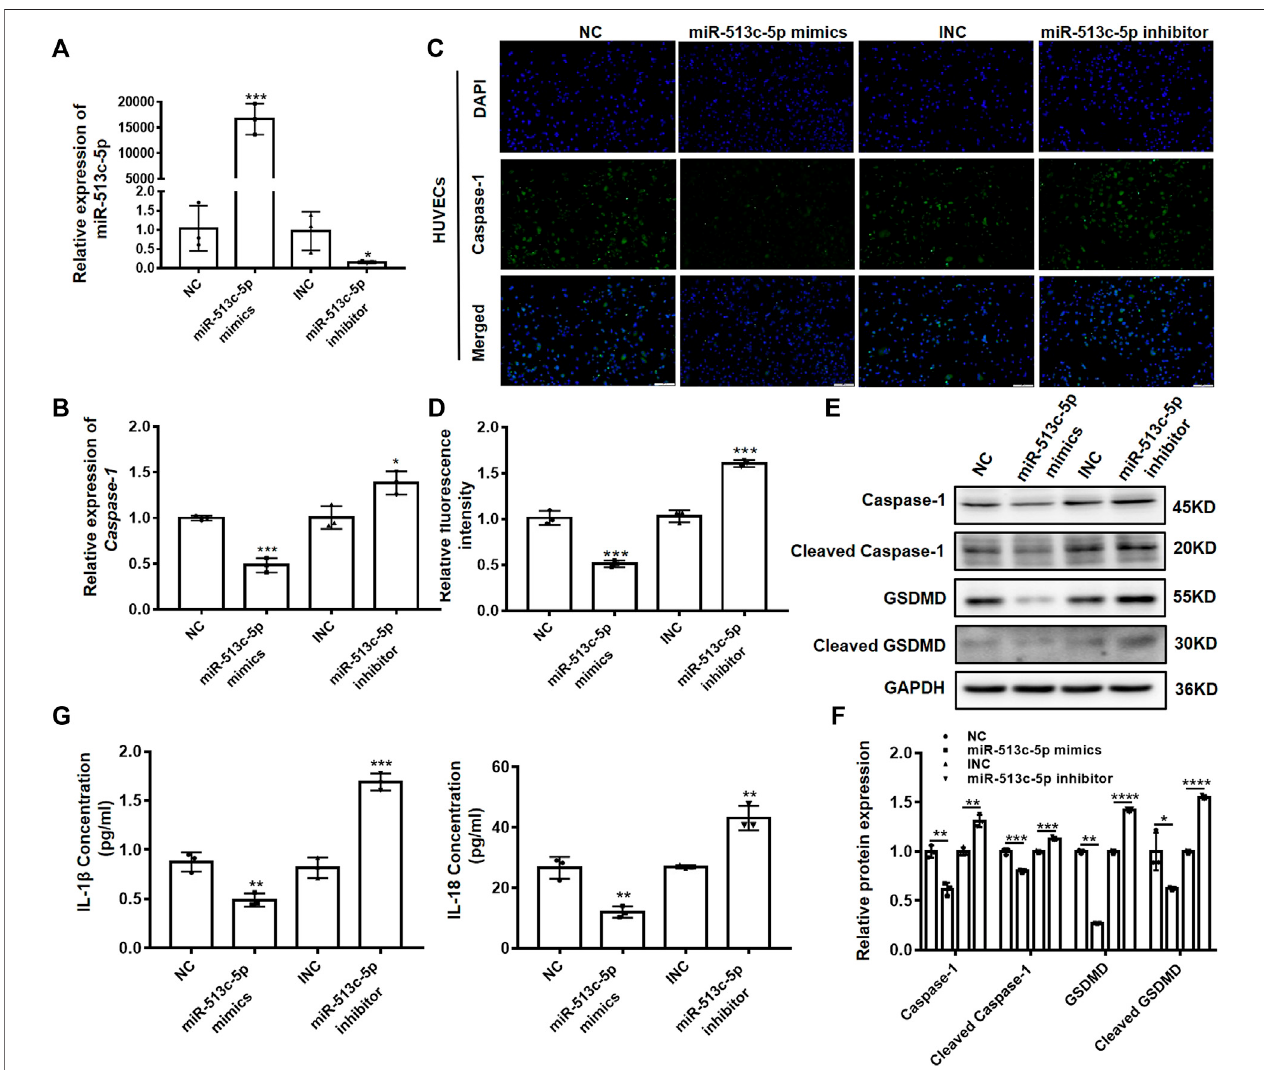
FIGURE 3 | miR-513c-5p negatively regulates caspase-1 expression in HUVECs. (A) The expression of miR-513c-5p after NC, miR-513c-5p mimics, INC and miR-513c-5p inhibitor transfection was evaluated by qRT-PCR. (B) The expression level of caspase-1 mRNA after NC, miR-513c-5p mimics, INC and miR-513c-5p inhibitortransfectionwasdetectedbyqRT-PCR. (C,D) Expressionofcaspase-1inHUVECsweredetectedaftertransfectionNC,miR-513c-5pmimics,INC,miR-513c- 5pinhibitorbyimmuno fl uorescencestaining(magni fi cation,×40).Scalebar=200 μ m. (E,F) Proteinexpressionlevelsofcaspase-1andGSDMDwereexaminedby Western blot. (G) The expression of IL-1 β and IL-18 was detected by ELISA. * p < 0.05, ** p < 0.01, and *** p < 0.001, **** p < 0.0001.